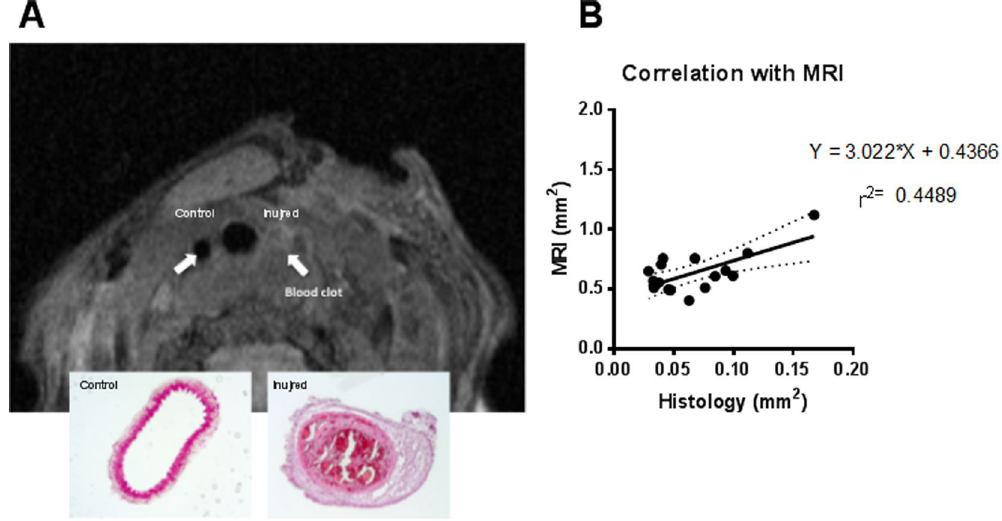
Figure 2. Magnetic resonance imaging on carotid arteries. ( A ) In vivo magnetic resonance imaging (MRI) and H&E staining from a C57BL/6 mouse subjected to wire injury in the left carotid artery. Following wire injury, the right carotid artery (control) appeared normal, whereas a blood clot obstructed the entire left (injured) carotid artery. ( B ) Correlation between MRI measurements and histological measurements of cross-sectional areas of injured carotid arteries. Values are averaged from 4 MRI cross-sections or 6–10 histological sections. n = 18. A statistically significant (p = 0.0045) correlation between MRI measured values and histology-derived values was